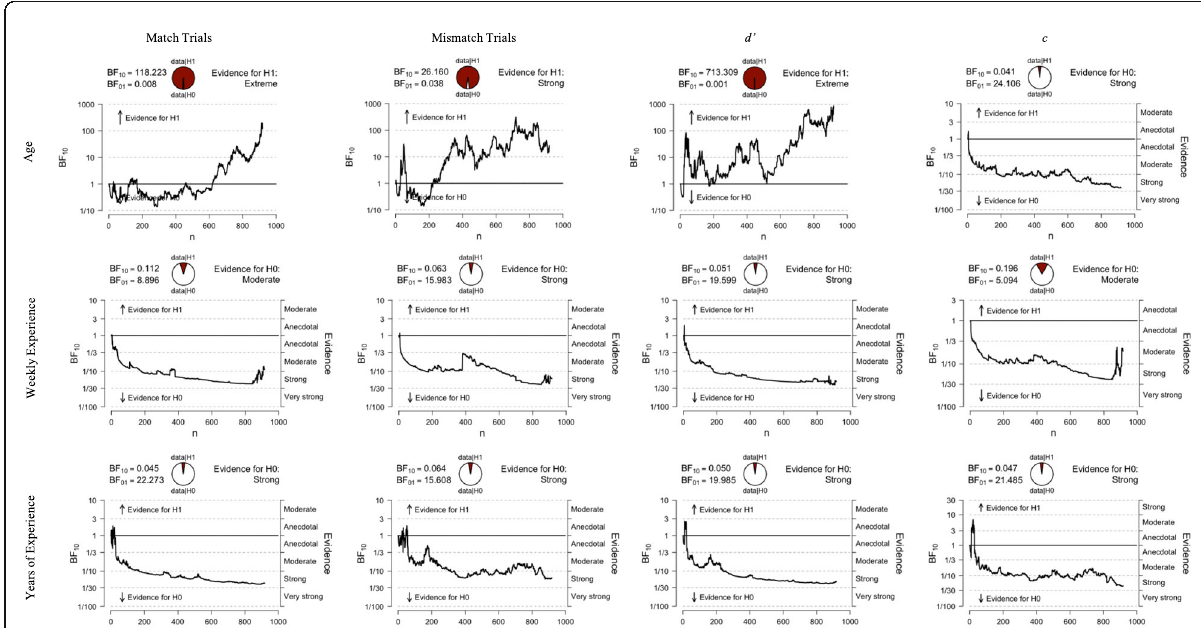
Fig. 5 Sequential analyses showing the influence of age (top row), weekly experience (middle row), and years of experience (bottom row) on match (left column) and mismatch (right column) accuracy. Resulting BF10 values are plotted as additional participants are added to the analysis, with evidence labels on the right of the graphs showing evidence favoring the null